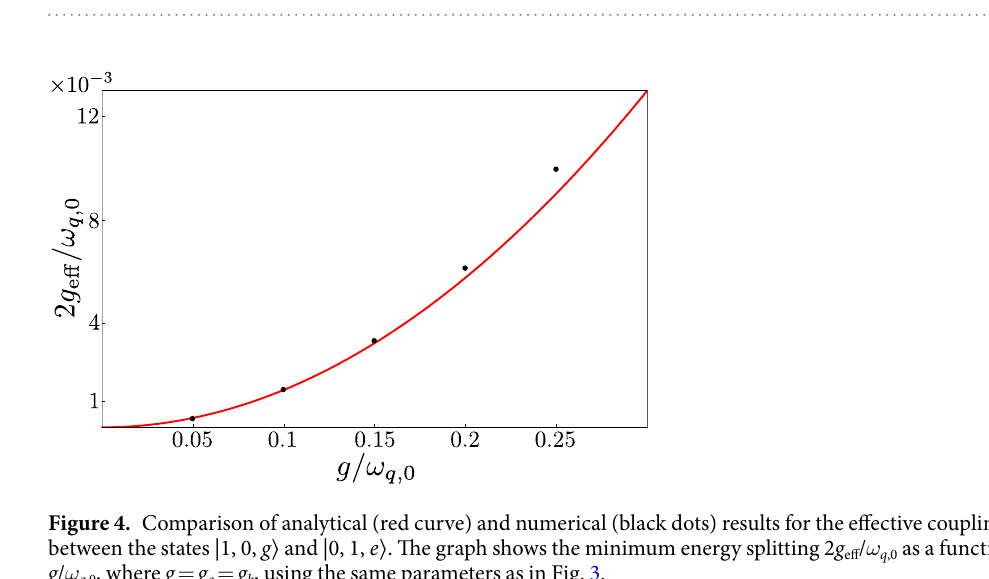
Figure 3. Two frequency conversion methods. (a) The figure shows the energy levels of our system plotted as a function of the qubit frequency ω q , using the parameters g a = g b = 0.15 ω q ,0 , θ = π /6, ω a = 3 ω q ,0 , and ω b = 2 ω q ,0 , where ω q ,0 is a reference point for the qubit frequency, set such that ω a = ω b + ω q ,0 . In the zoom-in, close to the resonance ω a = ω b + ω q , we see the anticrossing between |1, 0, g 〉 and |0, 1, e 〉 with splitting 2 g eff . Up- or down- conversion of single photons can be achieved by adiabatically tuning ω q to follow one of the energy levels in the figure from |1, 0, g 〉 to |0, 1, e 〉 , or vice versa. (b) A rapid frequency conversion can be achieved by starting in |1, 0, g 〉 , far from the resonance ω a = ω b + ω q , tuning the qubit frequency (pink solid curve) into resonance for half a Rabi period ( π /2 g eff ) and then sending a pulse (green solid curve) to deexcite the qubit. The pink solid curve is given by ω ω , a smoothed step function, where ω q , i is the initial qubit frequency, δω q is the change of the qubit frequency, Θ is the Heaviside step function, t i is the time when the qubit frequency starts to change, t f = t i + π /(2 A ), and A is a frequency setting the smoothness. The figure shows the number of excitations in the two resonators (red dashed-dotted curve for a , black dashed curve for b ) and the qubit (blue solid curve) during the process, including decoherence in the form of relaxation from the resonators and the qubit. The parameters used for the decoherence are = κ = γ = 4 × 10 − 5 ω κ a b q ,0 .